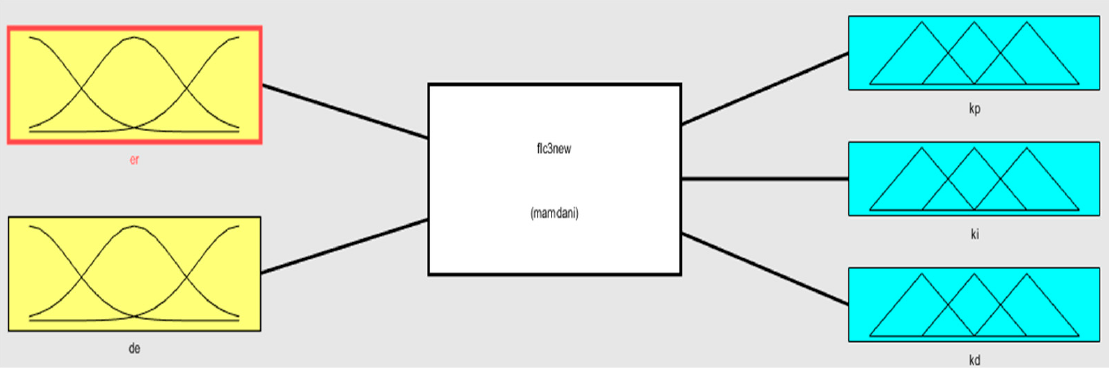
Figure 11. Two-input and three-output fuzzy inference system. After tuning PID parameters [10], the controller output is represented using Equa- tion (41).